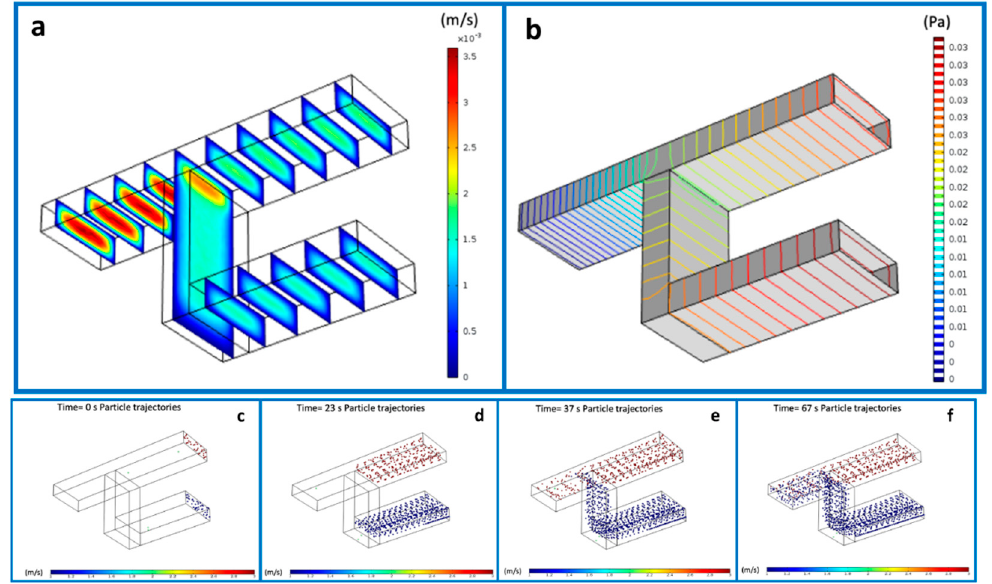
Figure 2. Simulated flow velocity ( a ) and pressure ( b ) in proximity of the interconnection point of the micromixing channel. Mixing of the two populations of nanoparticles at different time points, from the beginning of the experiment ( c ) at time 0 to the complete mixing obtained by ( d ): 23 seconds, ( e ): 37 seconds and accomplished after 67 seconds ( f ).